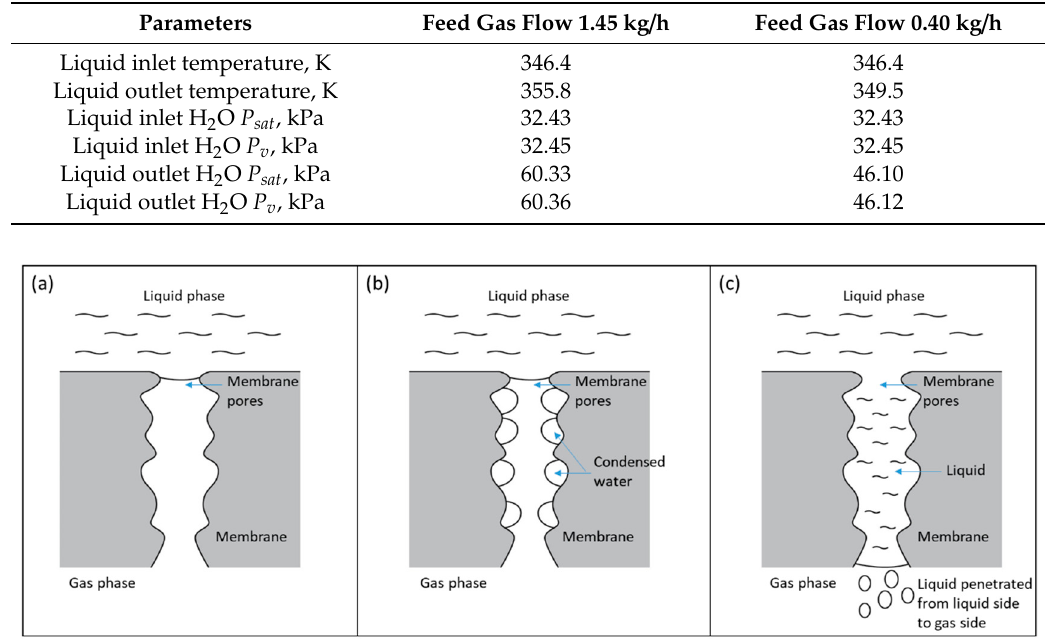
Table 5. Changes in water vapor pressures when feed gas flow rate was reduced.